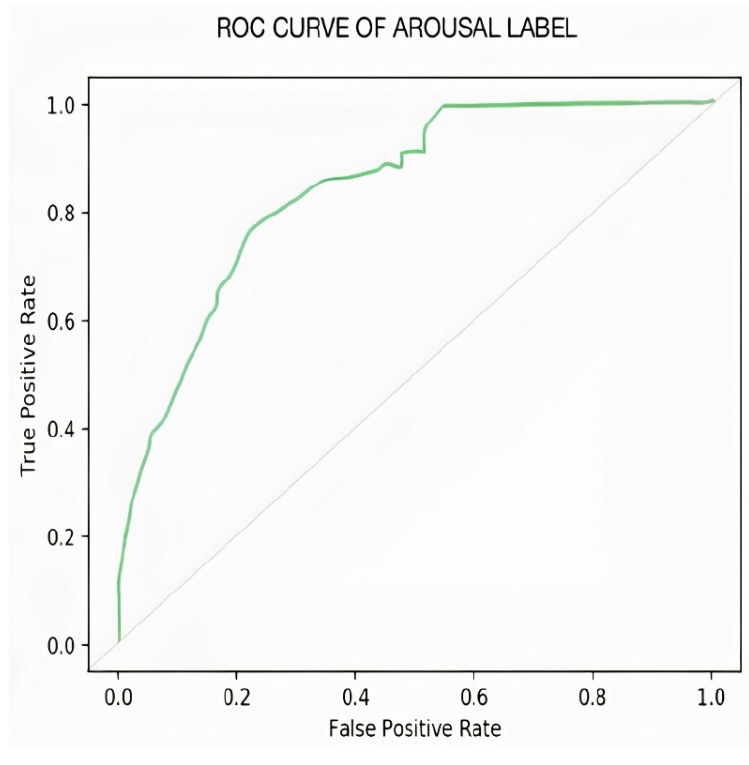
Figure 17. ROC curve of Arousal label.